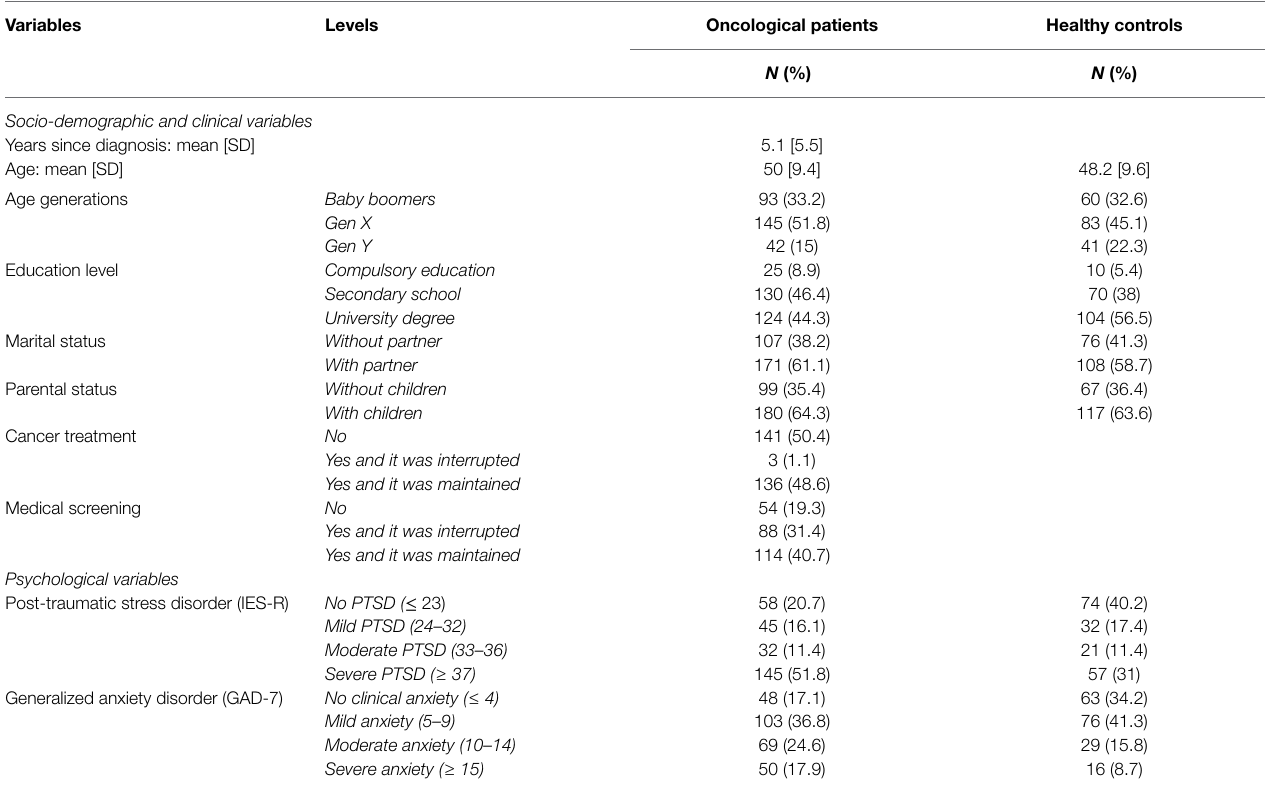
TABLE 1 | Socio-demographic, clinical, and psychological variables. Variables Levels Oncological patients Healthy